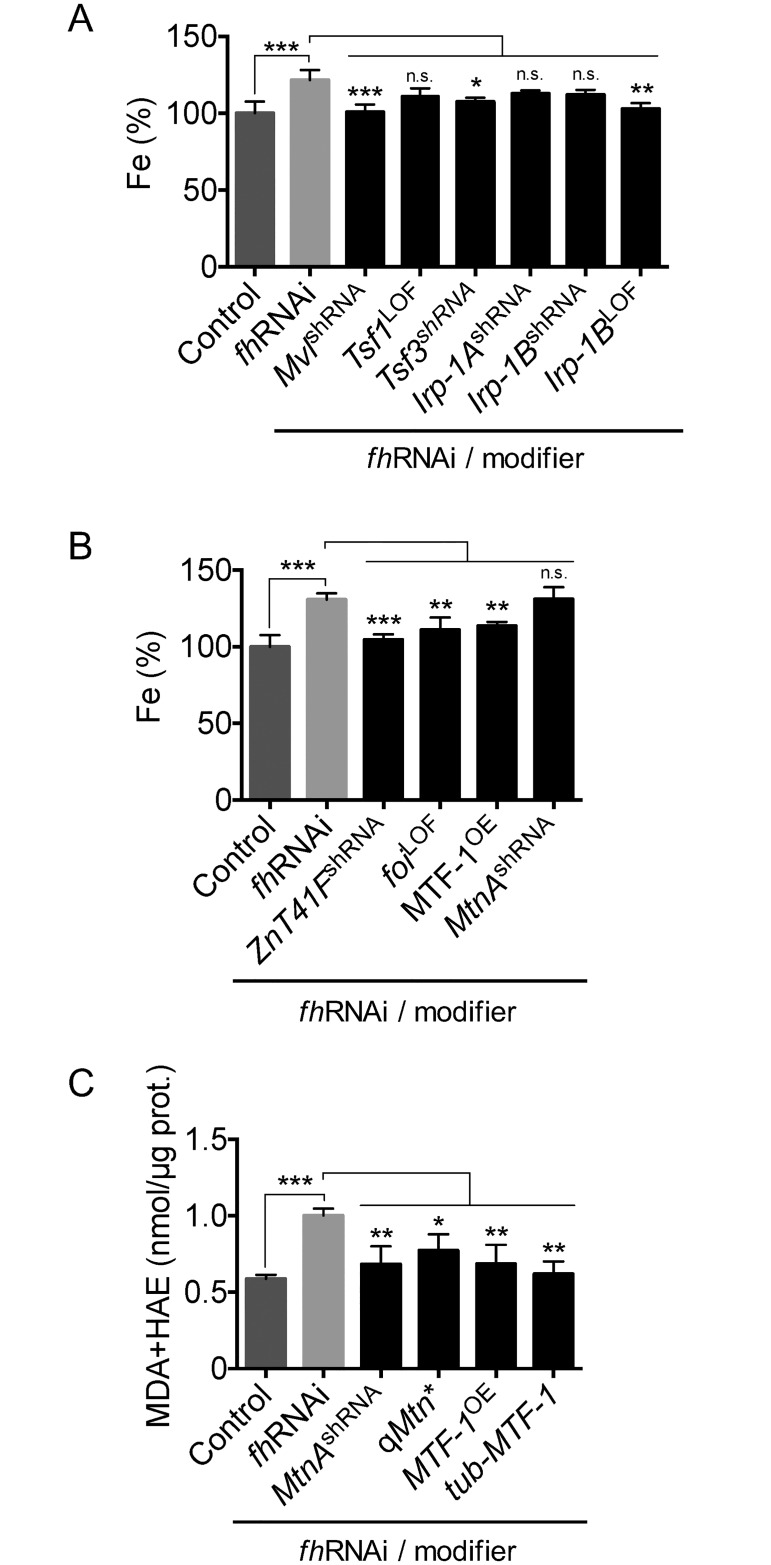
Genetic modifiers of the FRDA phenotypes reduce iron content and oxidative stress.A and B. Increased iron levels are rescued by modification of genes implicated in iron (A) and zinc homeostasis and metal detoxification (B). Total iron content was measured by atomic emission spectroscopy and expressed in percentage relative to the controls. C. Reduction of the increased levels of MDA+HAE by metal detoxification genes. The results are expressed in nmol of MDA+HAE per μg of protein. Error bars represent SEM. Control: w1118; actin-GAL4. fhRNAi: actin-GAL4>UAS-fhRNAi-2. fhRNAi/modifier: actin-GAL4>UAS-fhRNAi-2; modifier allele. Statistical significance was evaluated by ANOVA followed by Dunnet test for multiple comparisons. n.s.: non-significant, *P<0.05, **P<0.01, ***P<0.001. shRNA: knockdown allele. LOF: loss of function allele. OE: overexpression allele. qMtn*: loss of function of the four metallothioneins MtnA, MtnB, MtnC, MtnD.